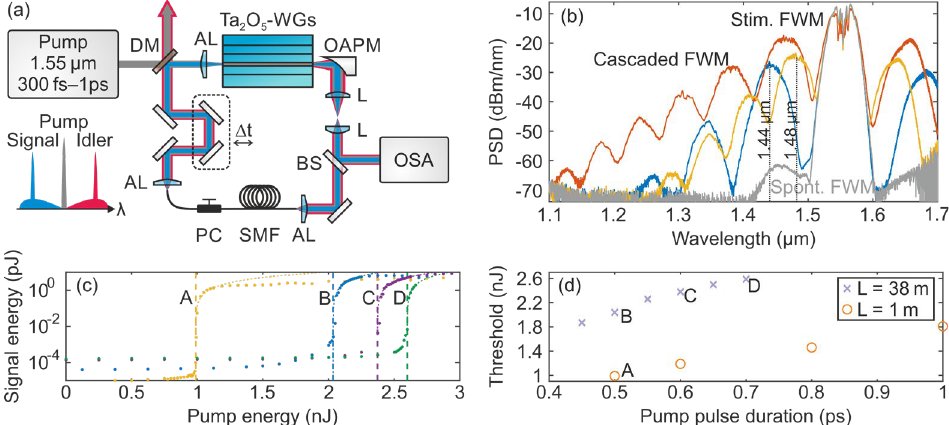
(a) Schematic experimental setup. (b) Spectra of spontaneous (gray) and stimulated FWM (colored) for three different delays Δ t (compare (a)). (c) Energy of the signal sideband (dots) as a function of the pump energy and linear fits (dotted) to determine the oscillation threshold (dashed) for four different parameter sets of pump pulse duration and feedback fiber length, as indicated in (d). (d) Oscillation threshold as a function of pump pulse duration. We fabricated ridge waveguides and used a 0.6 µm high, 1.7 µm wide and 10 mm long waveguide as the nonlinear gain medium. Fig. 1(a) shows that the waveguide was pumped at 1.55 µm center wavelength with 80 MHz repetition rate. The pump pulse duration was adjusted by means of a Fourier filter. Inside the waveguide, signal and idler sidebands were generated via spontaneous four-wave mixing (FWM). The signal sideband was temporally stretched in a fiber, overlapped with the next pump pulse, and fed back into the waveguide to stimulate the FWM process, as can be seen in Fig.